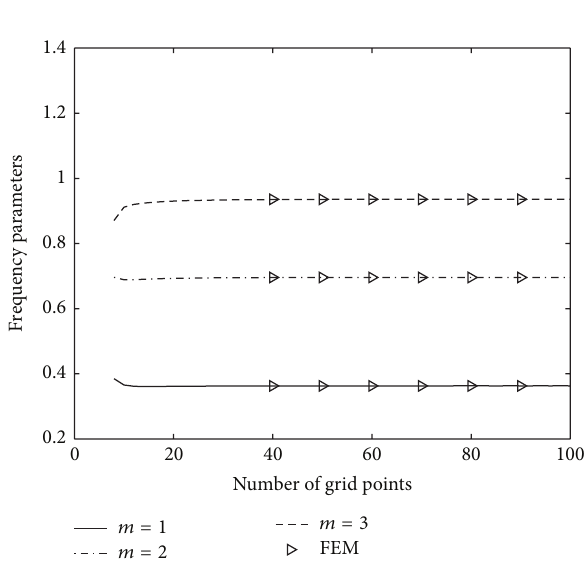
Figure 2: Natural frequency parameters under S-S boundary conditions ( 𝑛 = 0 , 𝑚 = 1,2, 3 ).